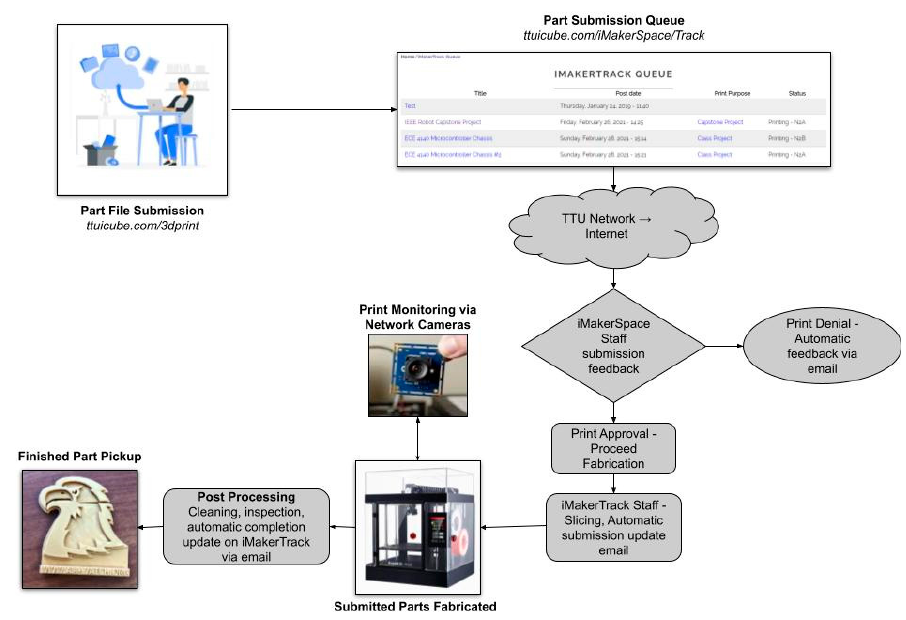
Figure 11. Structure of the iMakerTrack system .